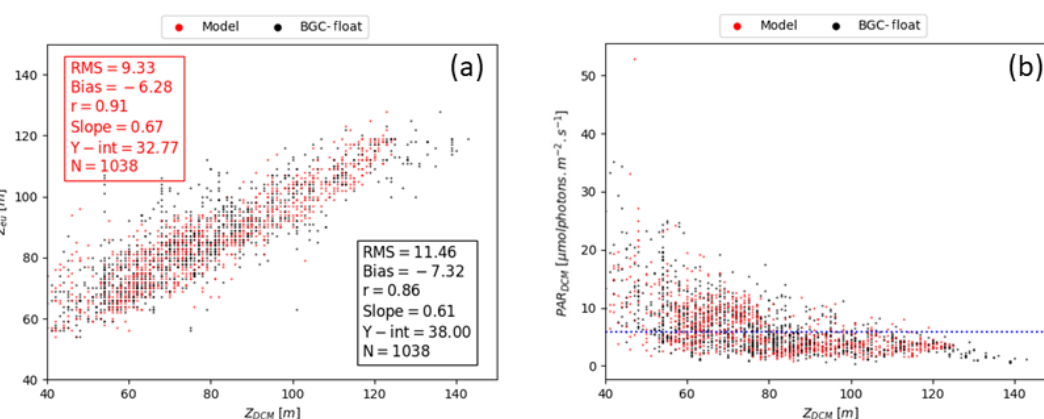
Figure 7. (a) DCM depth ( z DCM , x axis) compared to the euphotic depth ( z eu , y axis) for both modelled (red dot) and measured results (black dot). Red box (top left) reports statistics for model z DCM versus z eu , whereas the black box (bottom right) shows statistics for z DCM derived from Chl data versus z eu . (b) Irradiance values ( y axis) at DCM depth ( x axis) for both modelled (red dot) and measured results (black dot). Horizontal blue line marks the 5.8 irradiance threshold (units µmolphotonsm − 2 s − 1 ) as identified in Mignot et al.